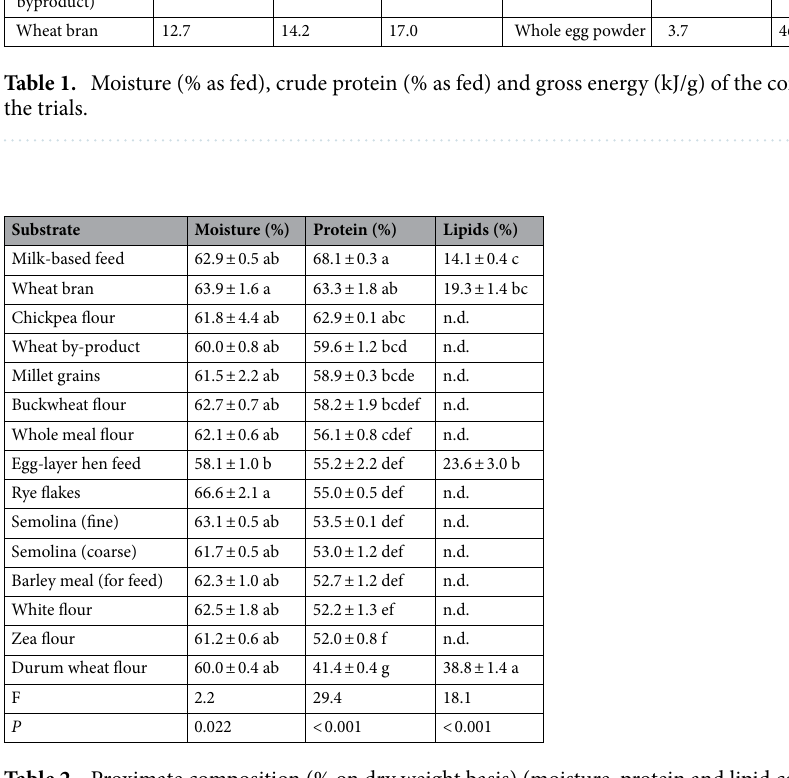
Table 2. Proximate composition (% on dry weight basis) (moisture, protein and lipid content) of Tenebrio molitor larvae fed with various substrates. Within each column, means followed by the same lowercase letter are not significantly different (for moisture and protein content df = 14, 44, whereas for lipid content df = 3, 11; Tukey–Kramer HSD test at P = 0.05). n.d. not determined.